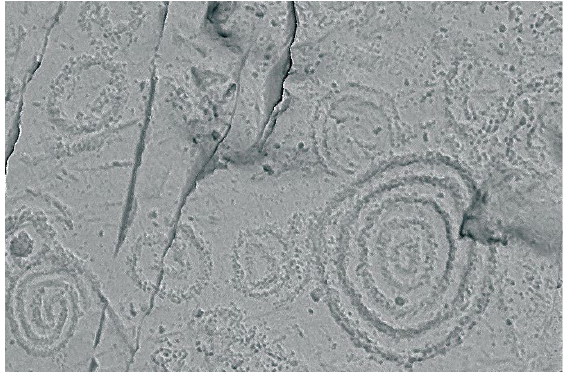
Figure 12a. A radiance scaling visualisation of a section of the SD model generated in MeshLab.